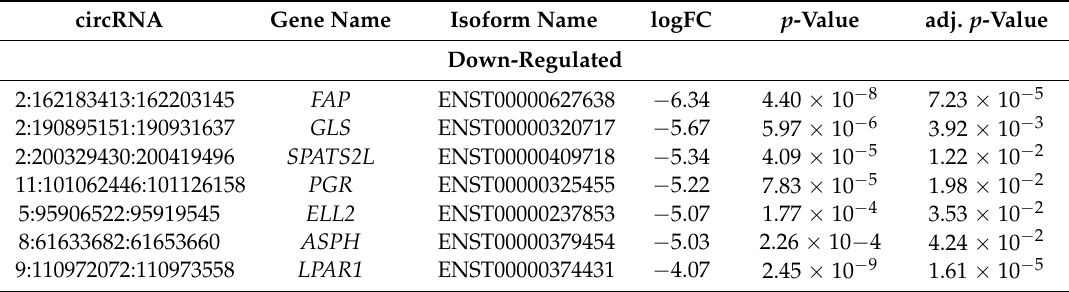
Table 3. Differentially expressed circRNAs in β -cells compared to α -cells. In total, 14 downregulated and 22 upregulated circRNAs were identified in β -cells using a cutoff of logFC ≥ 1 and adjusted p -value <